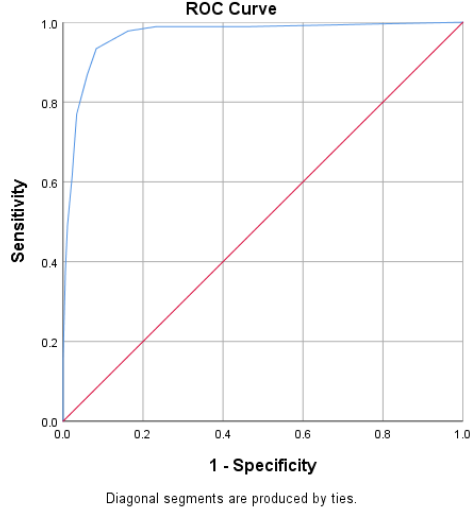
Figure 3. ROC curve for the PHQ-4.